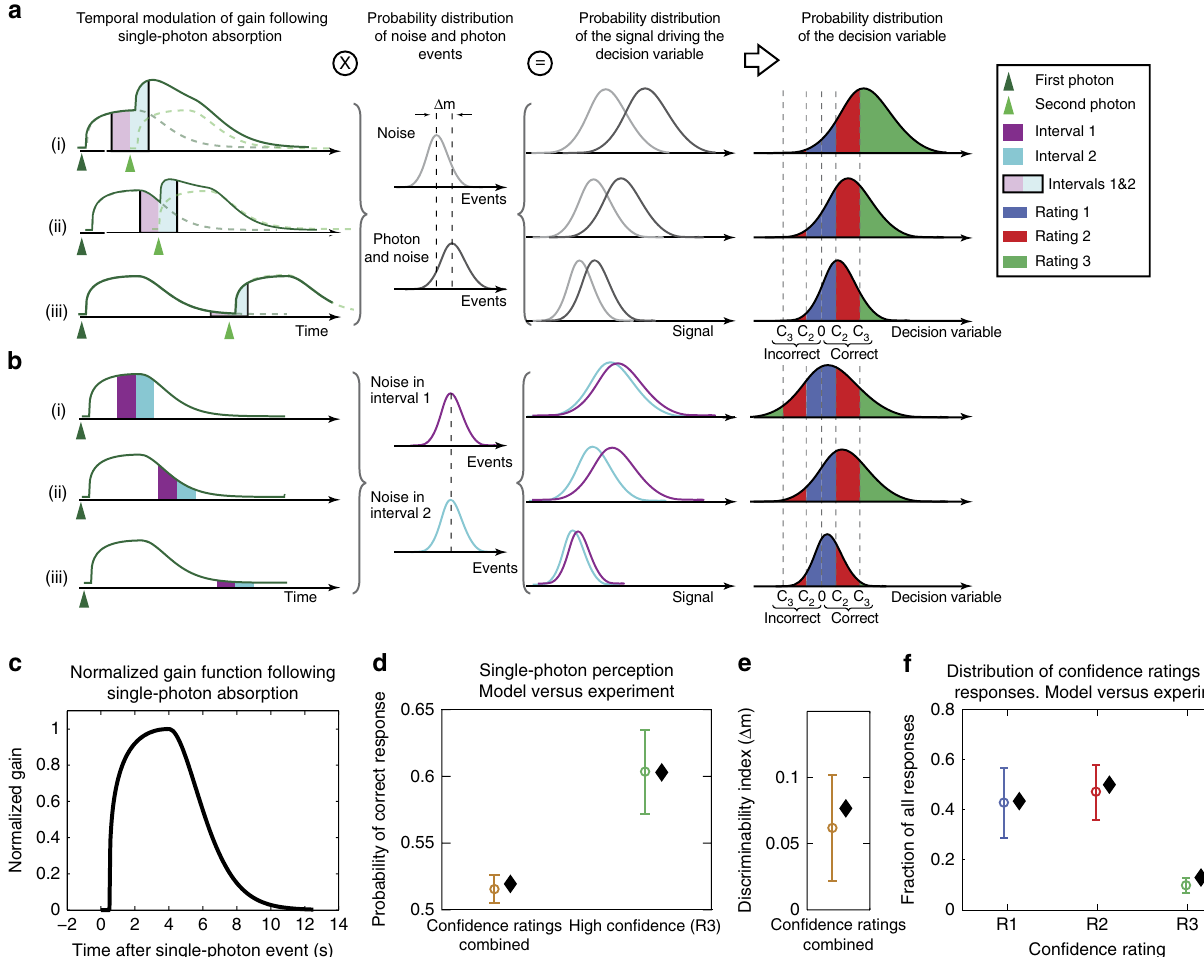
Figure 3 | Model for photon-induced priming of single-photon detection probability. ( a , b ) First column: temporal modulation of the effective gain following the absorption of two ( a ) or one ( b ) photons separated by three different time delays, corresponding to the respectively regions denoted in Fig. 2c,d (i–iii). Second column: probability distribution for photon plus photon-like noise events and photon-like noise events only during intervals 1 and